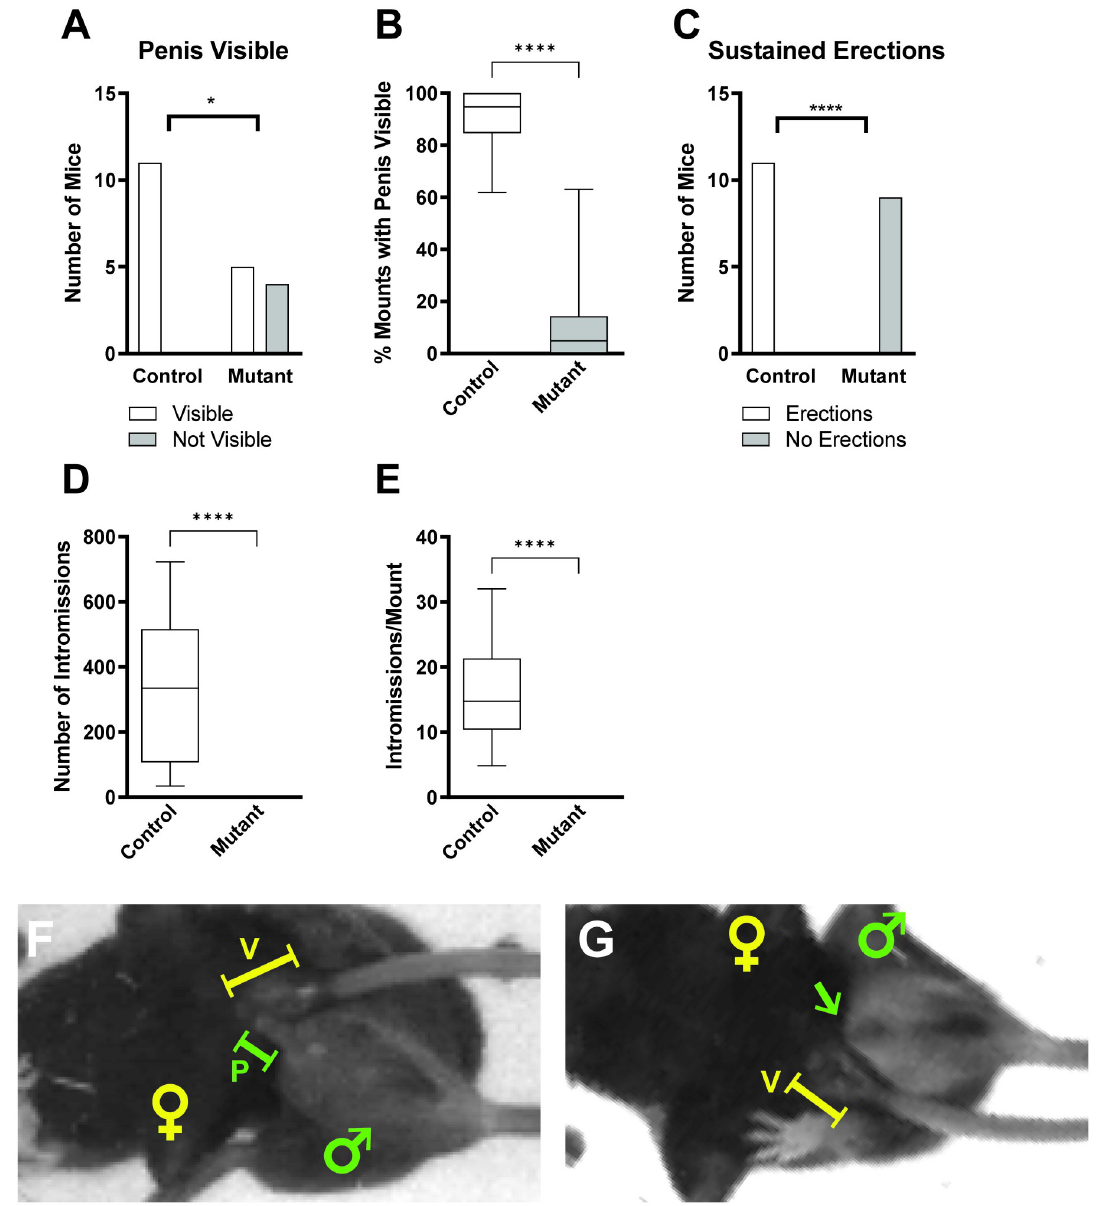
Fig 3. Pea3 null males have greatly diminished erectile functioning during sexual behavior. (A) Of mounting mice, there are fewer Pea3 null mice with the penis visible outside of the penile sheath compared to control mice (control: N = 11 mice; null: N = 9 mice; Fisher’s exact test, p < 0.026, � ). (B) Pea3 null mice exhibit a decreased percentage of mounts with the penis visible outside of the penile sheath during mounting behavior compared to control mice (control: 89.60 ± 3.87, N = 11 mice; null: 11.83 ± 6.72%, N = 9 mice; Mann- Whitney test, p < 0.0001, ���� ). (C) Of mounting mice, no Pea3 null mice exhibit sustained erections during sex as opposed to all control mice doing so (control: N = 11 mice; null: N = 9 mice; Fisher’s exact test, p < 0.0001, ���� ). (D and E) Pea3 null mice do not achieve intromission, as compared to control mice for the total number of intromissions performed (D; control: 331.20 ± 68.32 intromissions, N = 11 mice; null: 0.0 ± 0.0 intromissions, N = 9 mice; Mann-Whitney test, p < 0.0001, ���� ) and the number of intromissions per mount (E: control: 16.71 ± 2.75 intromissions/mount, N = 11 mice; null: 0.0 ± 0.0 intromissions/mount, N = 9 mice; Mann-Whitney test, p < 0.0001, ���� ). Representative images of the presence (control mice; F) or absence ( Pea3 null mice; G) of erectile function. Male and female positions are marked by green and yellow symbols, respectively. Green capped lines and arrows indicate the position of the penis (P), and yellow capped lines indicate the position of the vagina (V).